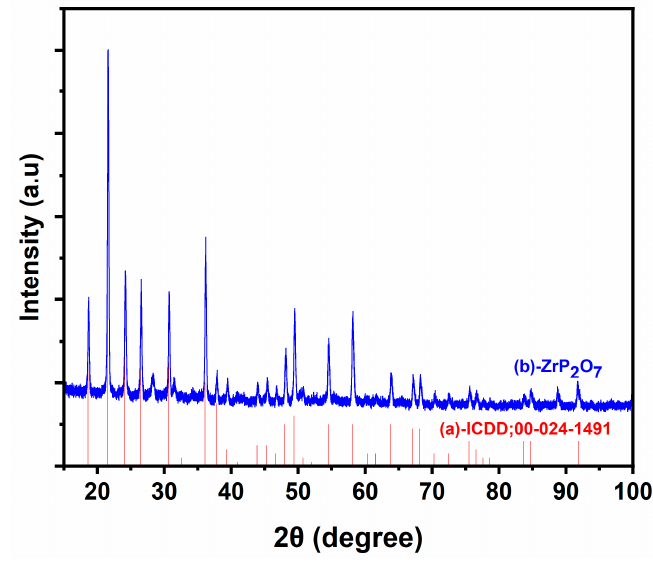
Figure 1. XRD pattern of ZrP 2 O 7 .